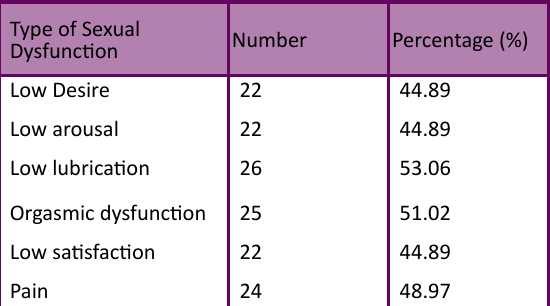
Table 1 – Type of sexual dysfunction according to